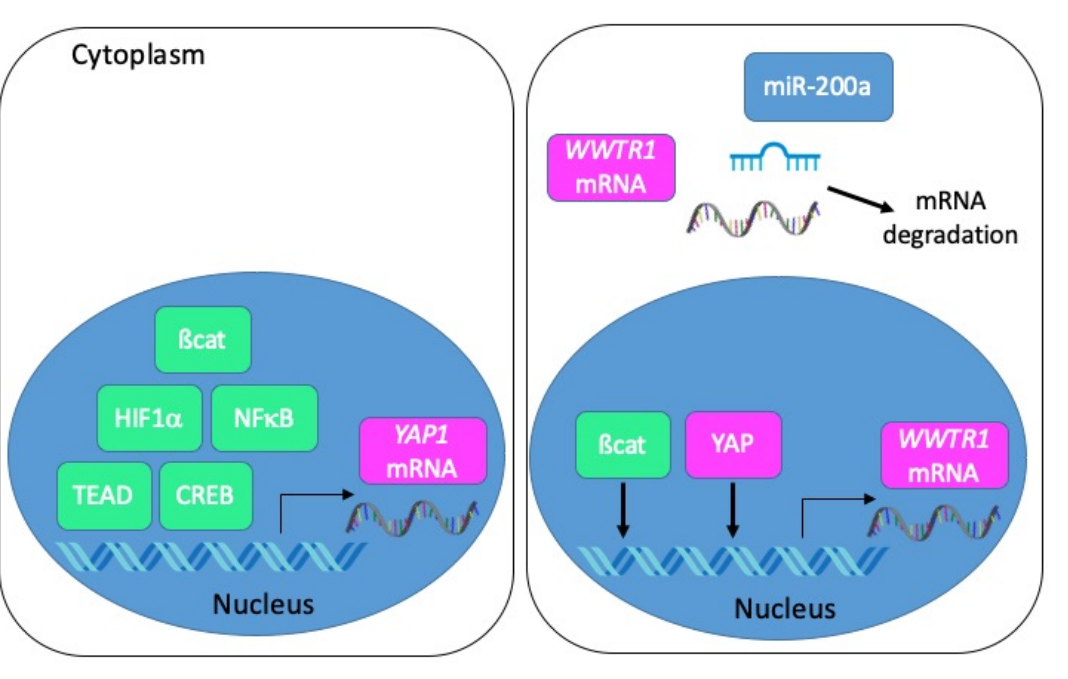
Figure 5. Mechanisms of YAP/TAZ transcriptional and post-transcriptional regulation in CRC. Left panel: the transcription of the YAP1 gene is positively regulated by ß-catenin, HIF1α, NFκB, TEAD or CREB. Right panel: the transcription of the WWTR1 gene is positively regulated by ß-catenin and YAP. Transcripts encoding TAZ are negatively regulated by miR-200a.